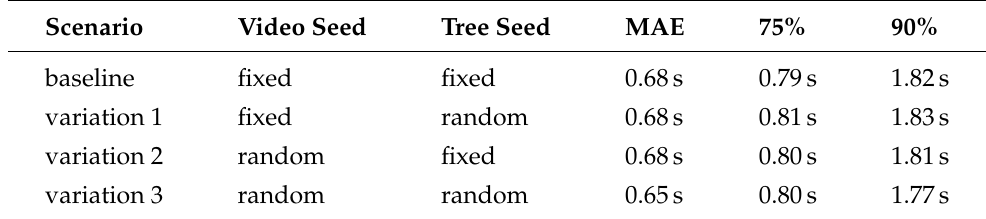
Table 11. Model variation